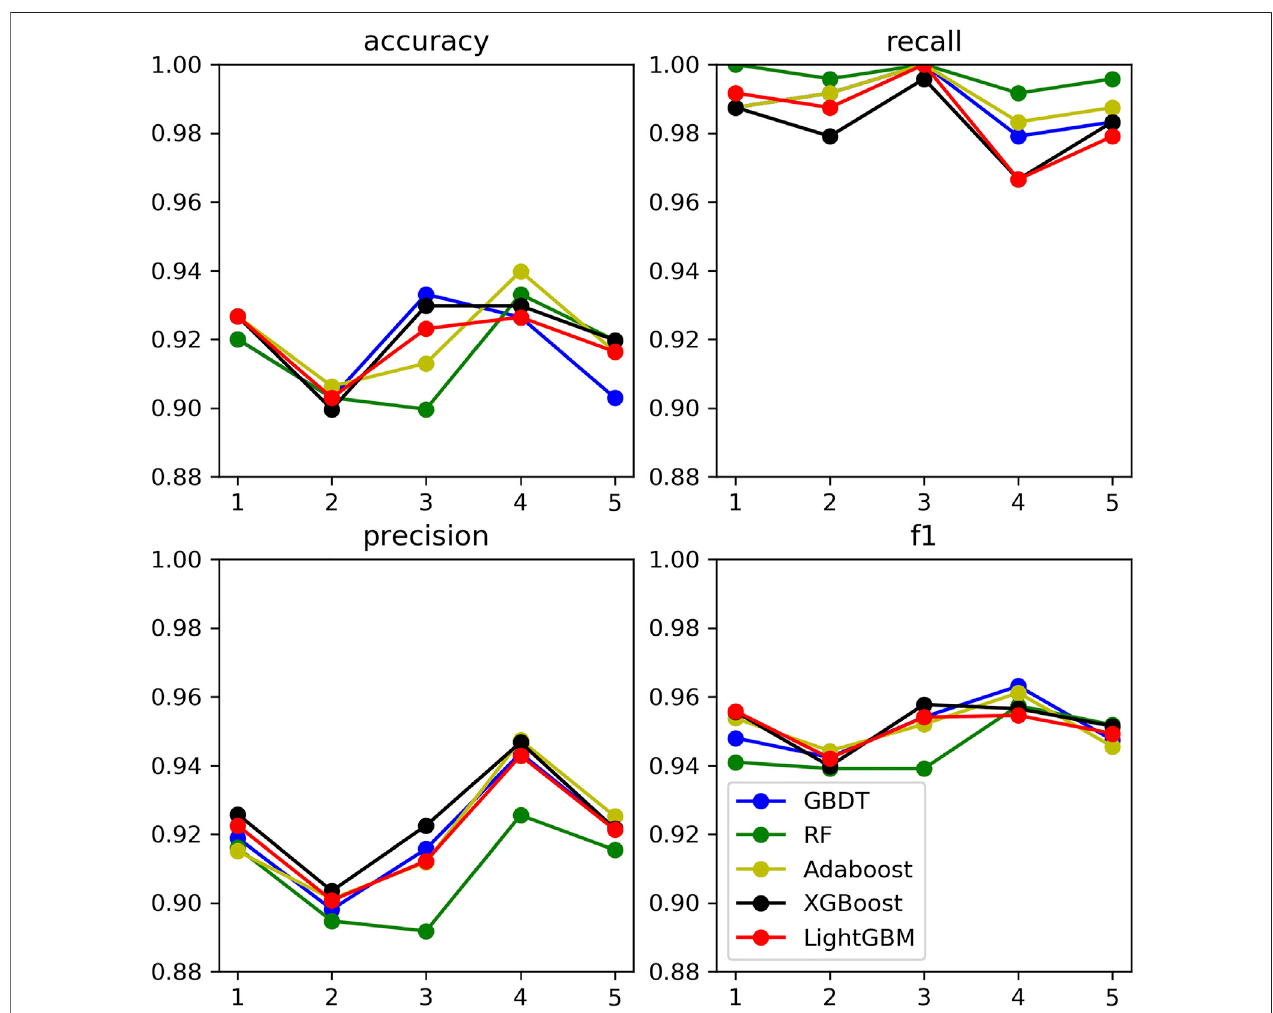
FIGURE 9 | Evaluation of fi ve models of Botrytis cinerea